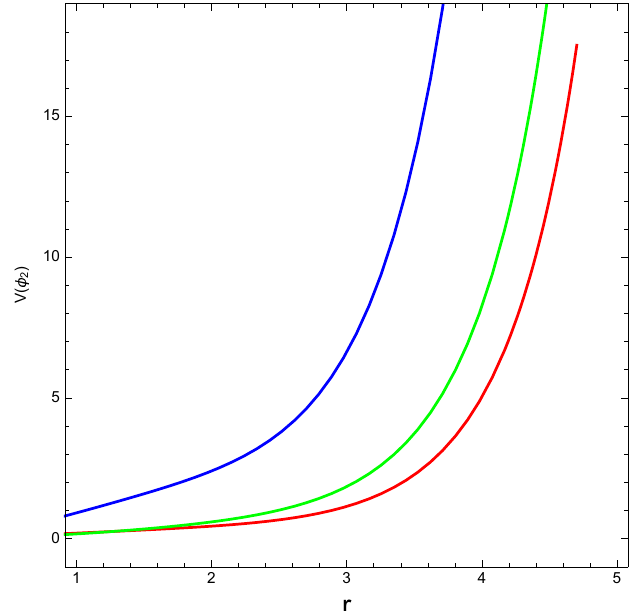
Figure 9. Solution of the scalar potential for R adopted as a quadratic function of radius. The evolution of the scalar potential V ( φ 2 ) is obtained by Equations (7) and (32). We have fixed the values of η 2 , η 3 , a 0 , a 1 , a 2 , K , and C 1 . The red, green, and blue lines correspond to small perturbations of λ 0 , Ψ 0 , and η 1 , respectively.